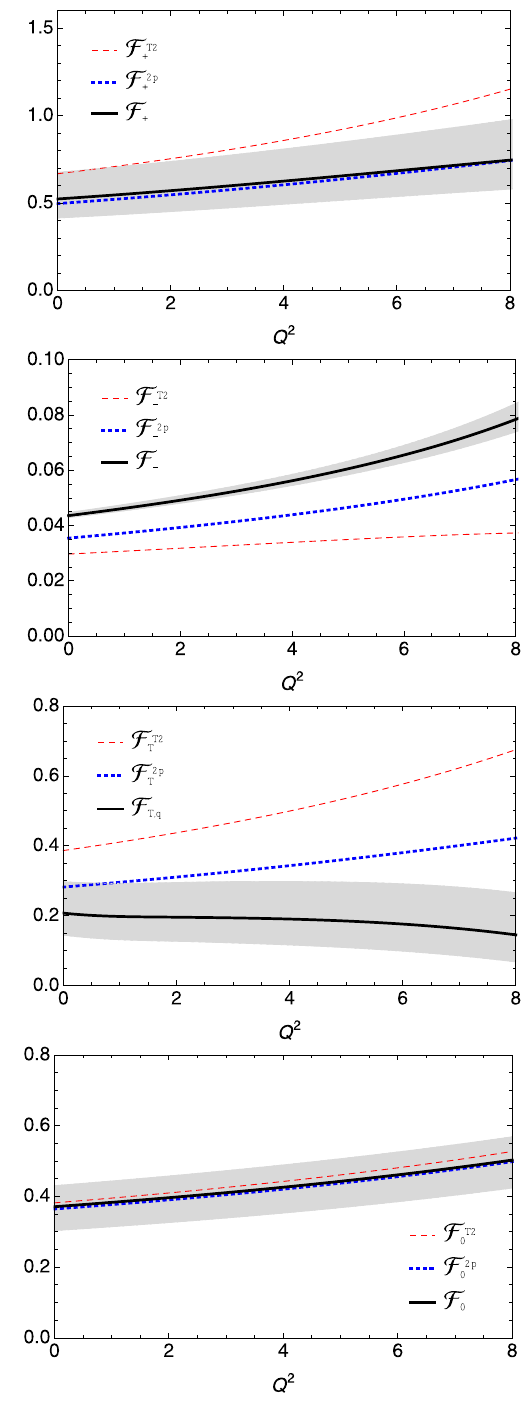
Fig. 1 LCSRs predictions for ¯ B s → f 0 form factors with Q 2 = q 2 , wherethered-dashedandblue-dottedcurvesrepresentthecontributions with considering only the leading twist and also the high twists two- particle DAs of ¯ B s meson, respectively. The black curves indicate the form factors obtained with including both two- and three-particle